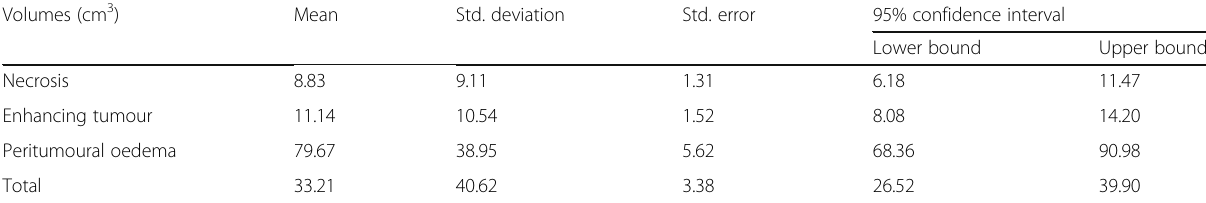
Table 3 Tumour regions volumes (cm 3 ) observed in GB Volumes (cm 3 )